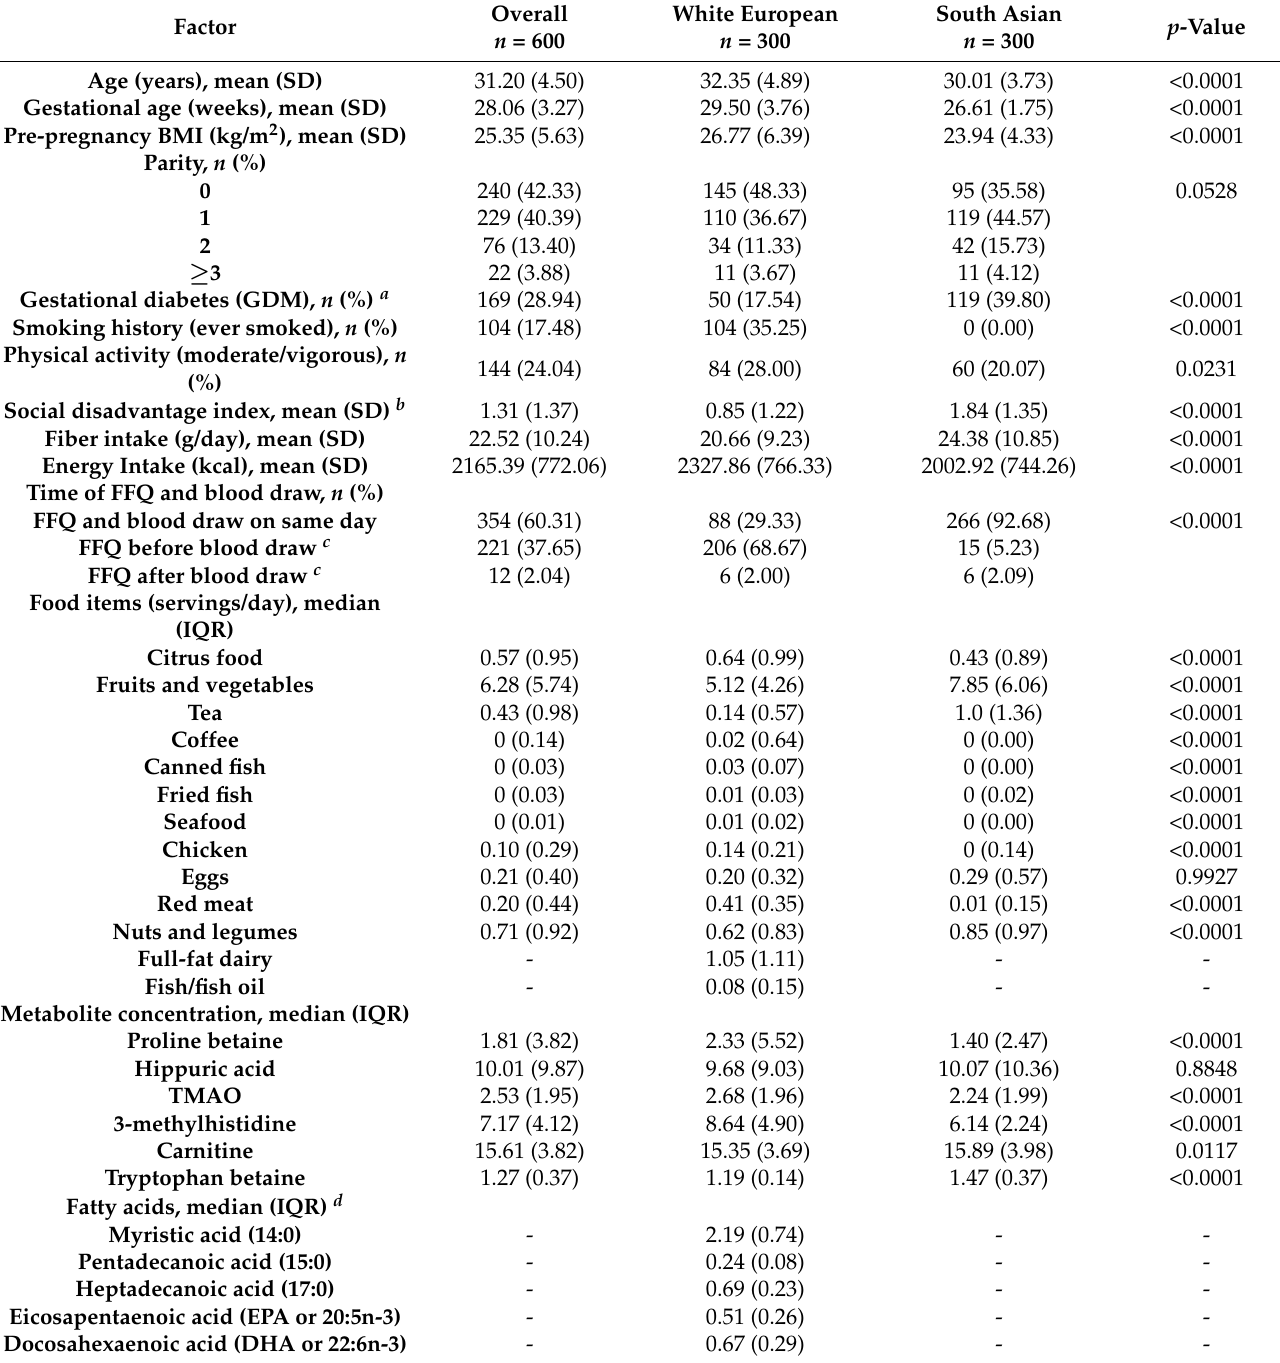
Table 1. Descriptive statistics of participants overall and by